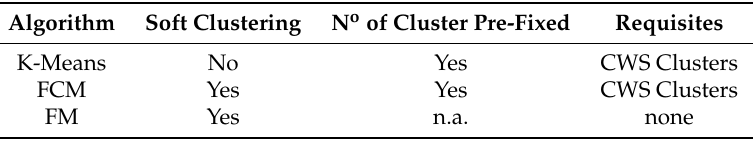
Table 1. Main features of the targeted clustering